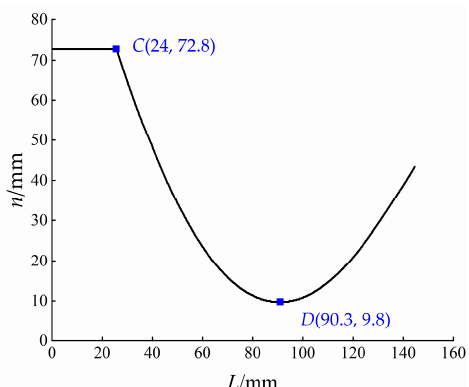
Figure 9. The simulation result of distance of finger end. Note: C is where the constraint part touches the finger. D is the position at which the finger ends converge to the minimum.